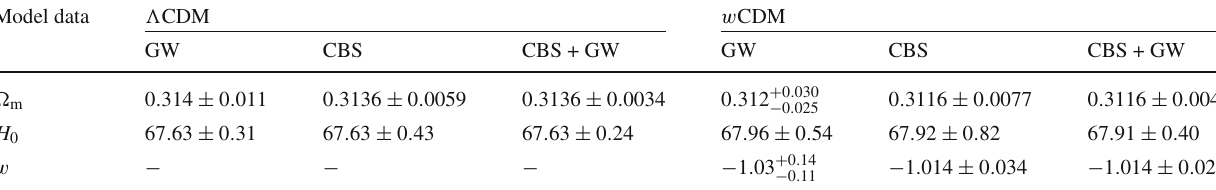
Table 1 Fitting results (68.3% confidence level) for the (cid:3) CDM model and the w CDM model using GW, CBS, and CBS + GW. Here, CBS stands